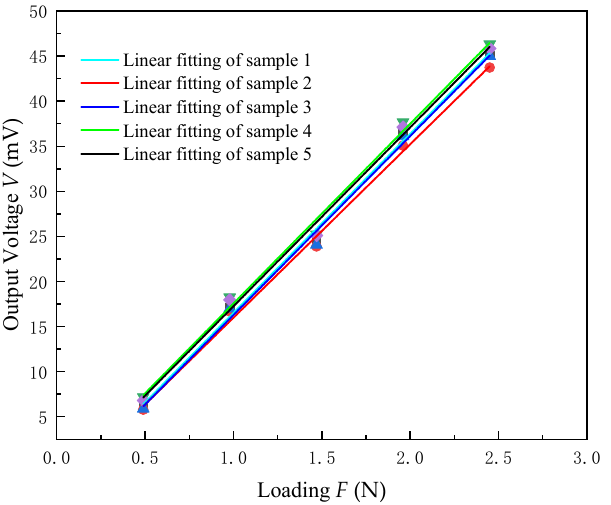
Figure 12. Voltage output characteristic curves of five piezoelectric film sensor samples under different pressures.